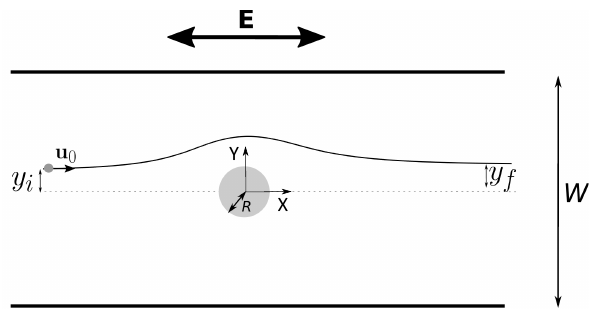
Figure 1. Schematics of the problem. Particles enter the channel from the left side driven by the fluid flow with velocity u 0 . There is an ac electric field applied in the system. The particle trajectories are affected by the presence of an insulating post. The particle-post interaction arises from different mechanisms of electrical